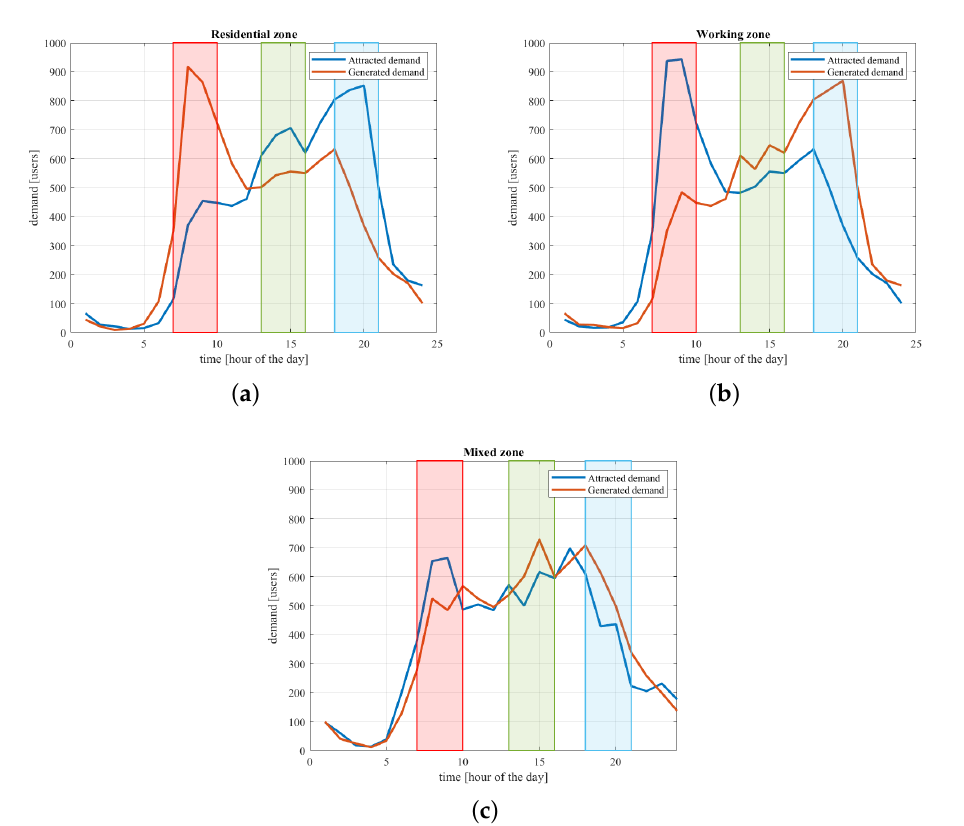
Figure 4. Example of typical daily dynamics of total mobility demand for ( a ) residential, ( b ) working, and ( c ) mixed zones. The coloured rectangles refer to morning (red), afternoon (green) and evening (blue) time